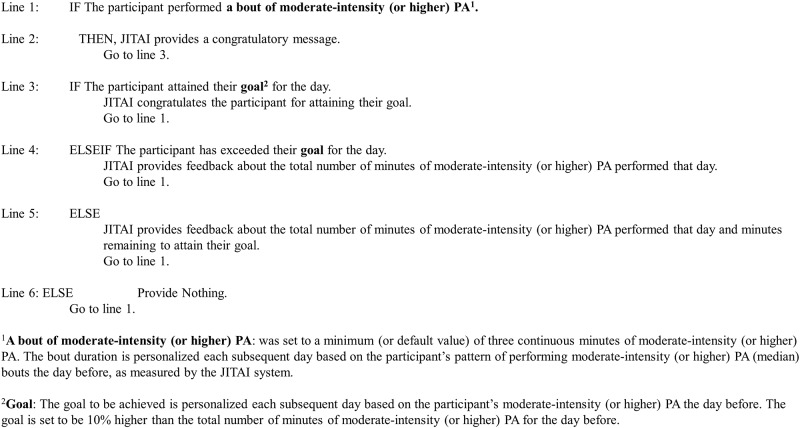
IF-Then rules used to design the JITAI notifications for the PA Feedback with JITAI phase of the study.